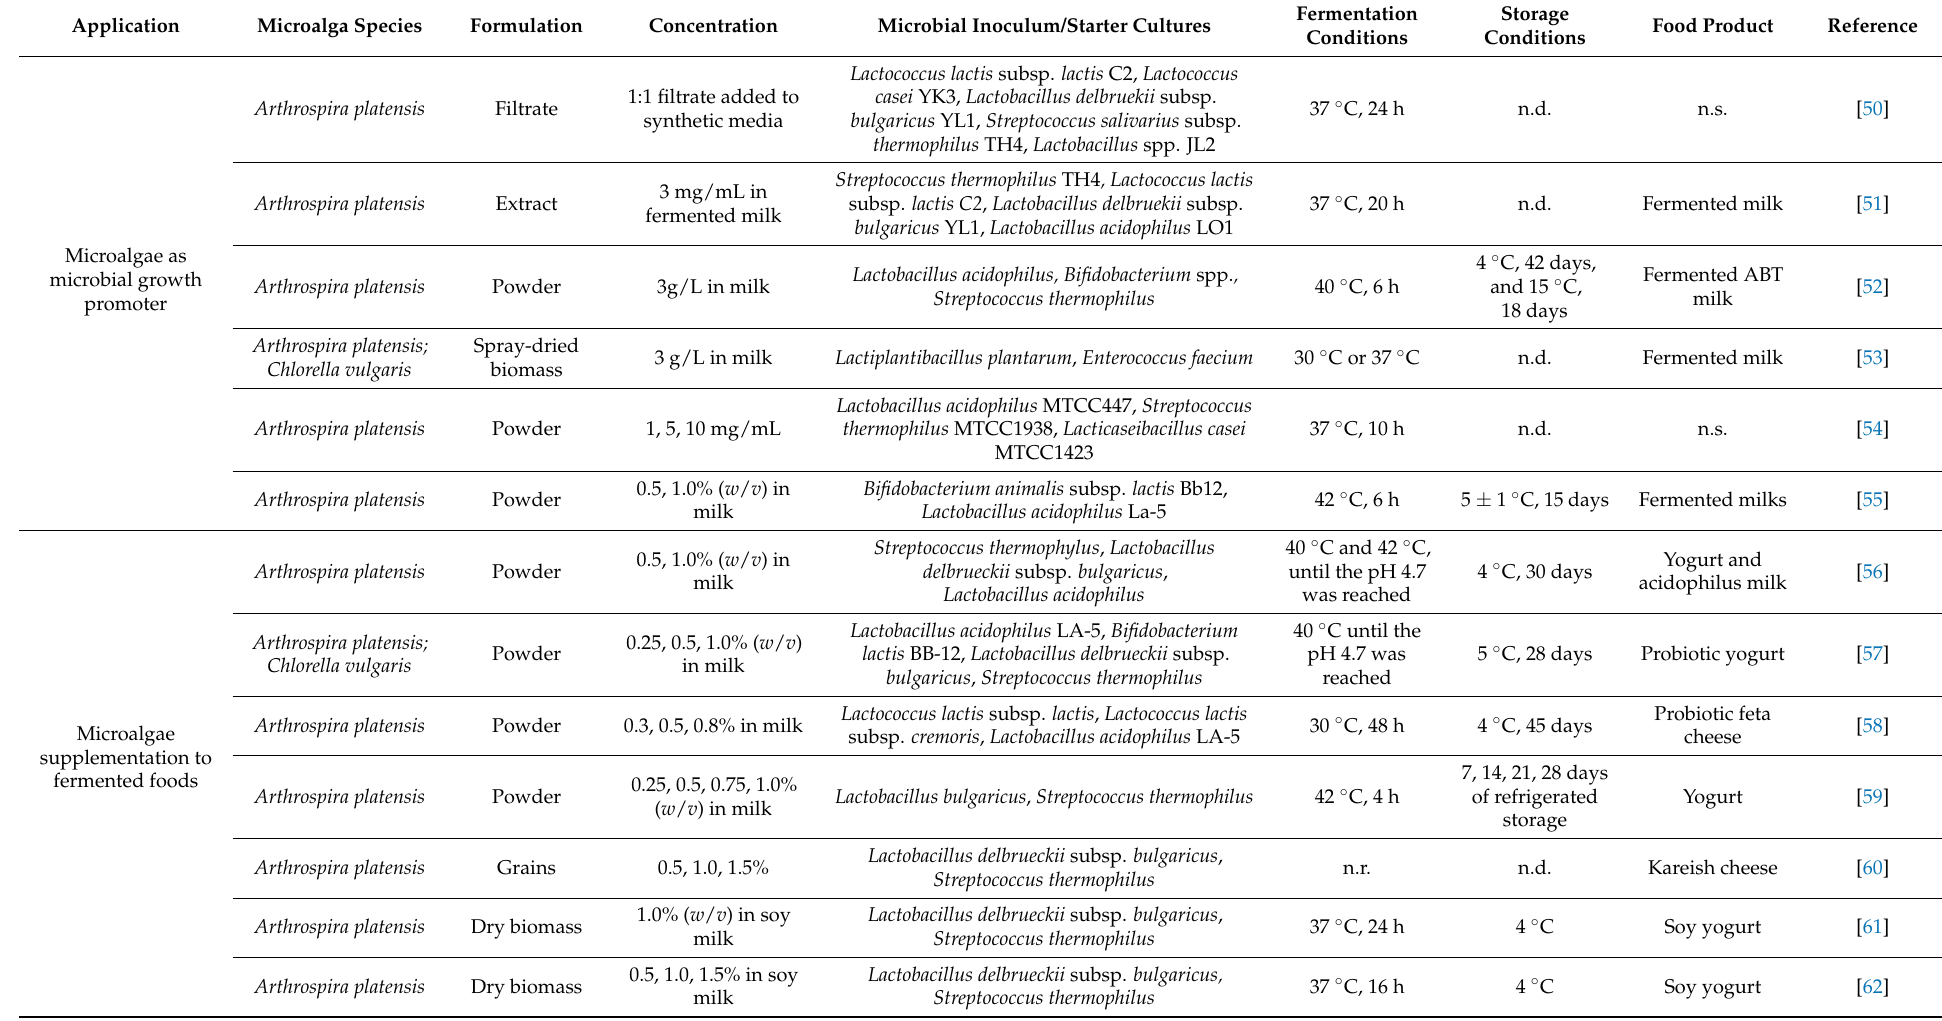
Table 2. Studies on microalgal fermentation for food